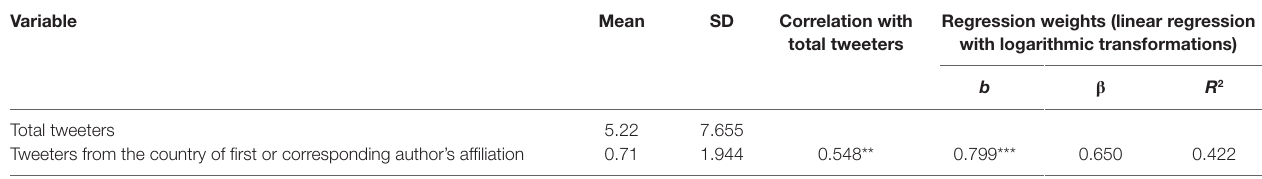
Table 7 | summary statistics, correlations and results from the regression